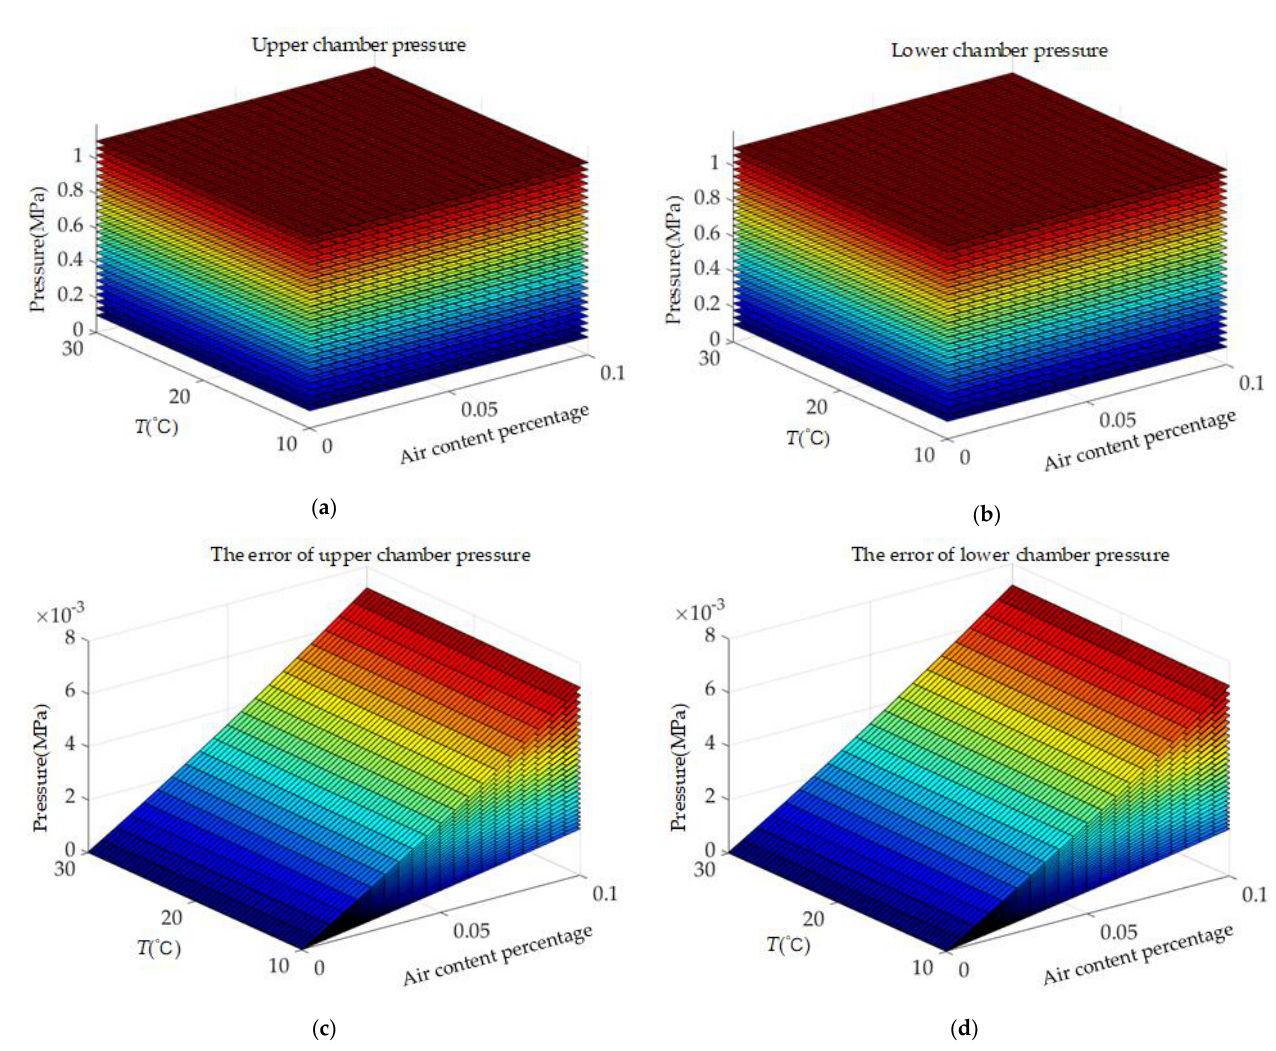
Figure 6. Support pressure is affected by change in ambient temperature and air content. ( a ) The pressure of upper chamber. ( b ) The pressure of lower chamber. ( c ) The error of upper chamber pressure. ( d ) The error of lower chamber pressure.